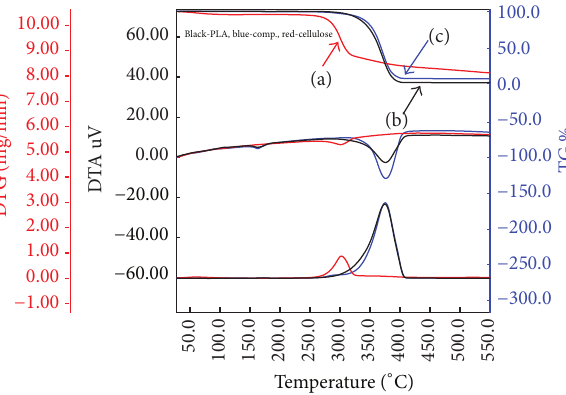
Figure 4: Comparison of TG/DTA and DTG value of (a) cellulose crystals (red), (b) PLA (black), and (c) biocomposite